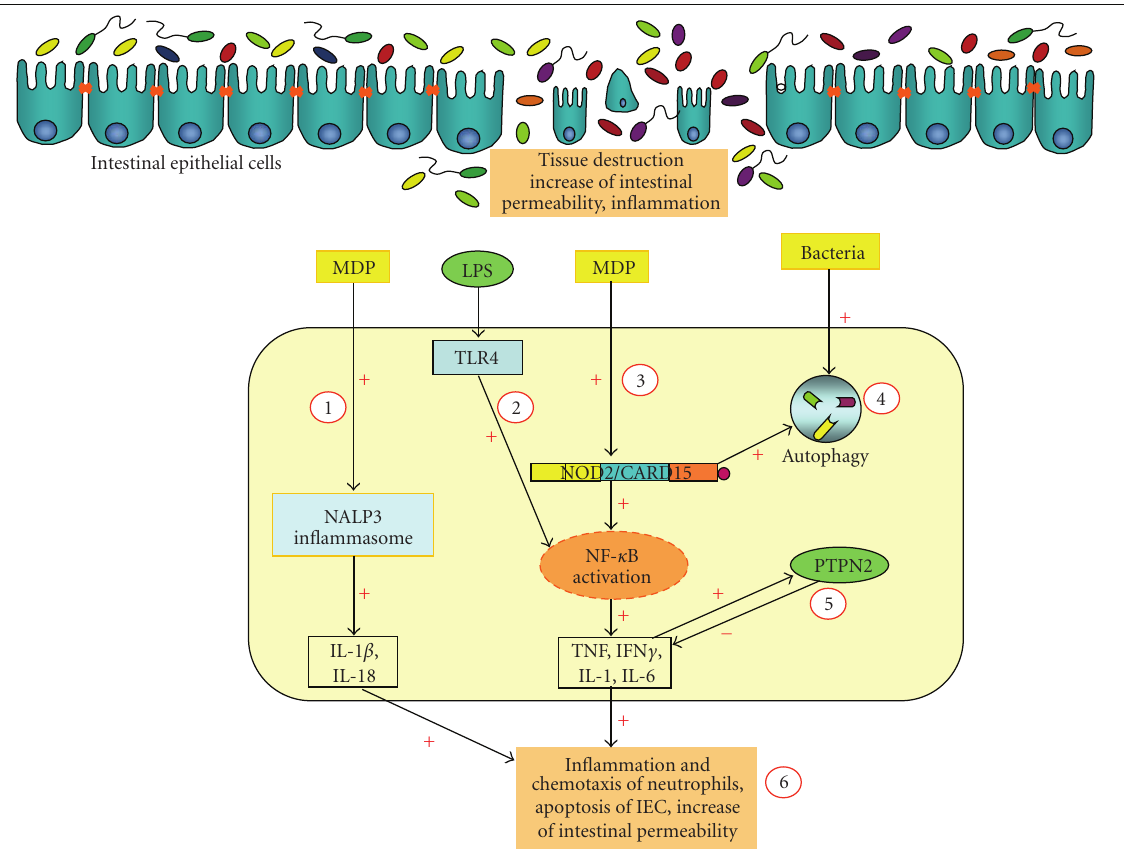
Figure 3: The innate immune system during intestinal inflammation. A defect in the intestinal epithelium, possibly genetically driven, causing tissue destruction, increased epithelial permeability and inflammation permits bacteria and their antigens, such as LPS and MDP, to penetrate through the epithelial monolayer. (1) The bacterial wall component, peptidoglycan, is cut by intracellular endosomes to MDP, that can activate the NALP3 inflammasome. As a consequence, pro-IL1 β and pro-IL18 are processed to active molecules, what triggers proinflammatory conditions in the epithelium. (2) LPS binding to its receptor, TLR4, results in the activation of NF- κ B and, subsequently, in increased expression of cytokines, such as TNF, IFN γ , or IL6. (3) MDP activates NOD2 directly, causing increased NF- κ B activity. In addition to elevated cytokine levels, NOD2 also induces the expression of antimicrobial peptides, such as defensins. (4) Bacteria, such as E. coli or Listeria monocytogenes , can activate the autophagosome that plays a key role for inactivating invasive bacteria and other pathogenic components. The autophagy machinery is also regulated by NOD2 activity. (5) Cytokines, such as IFN γ , have been shown to increase the activity of PTPN2 that, in turn, downregulates proinflammatory signalling. Dysfunction of PTPN2 results in an impaired epithelial barrier function and elevated secretion of proinflammatory cytokines. (6) Malfunction of the innate immune response mechanisms in the gastrointestinal tract, possibly genetically triggered, causes tissue destruction, increased apoptosis of intestinal epithelial cells, elevated epithelial permeability, and, finally, establishes a chronic inflammatory state in the